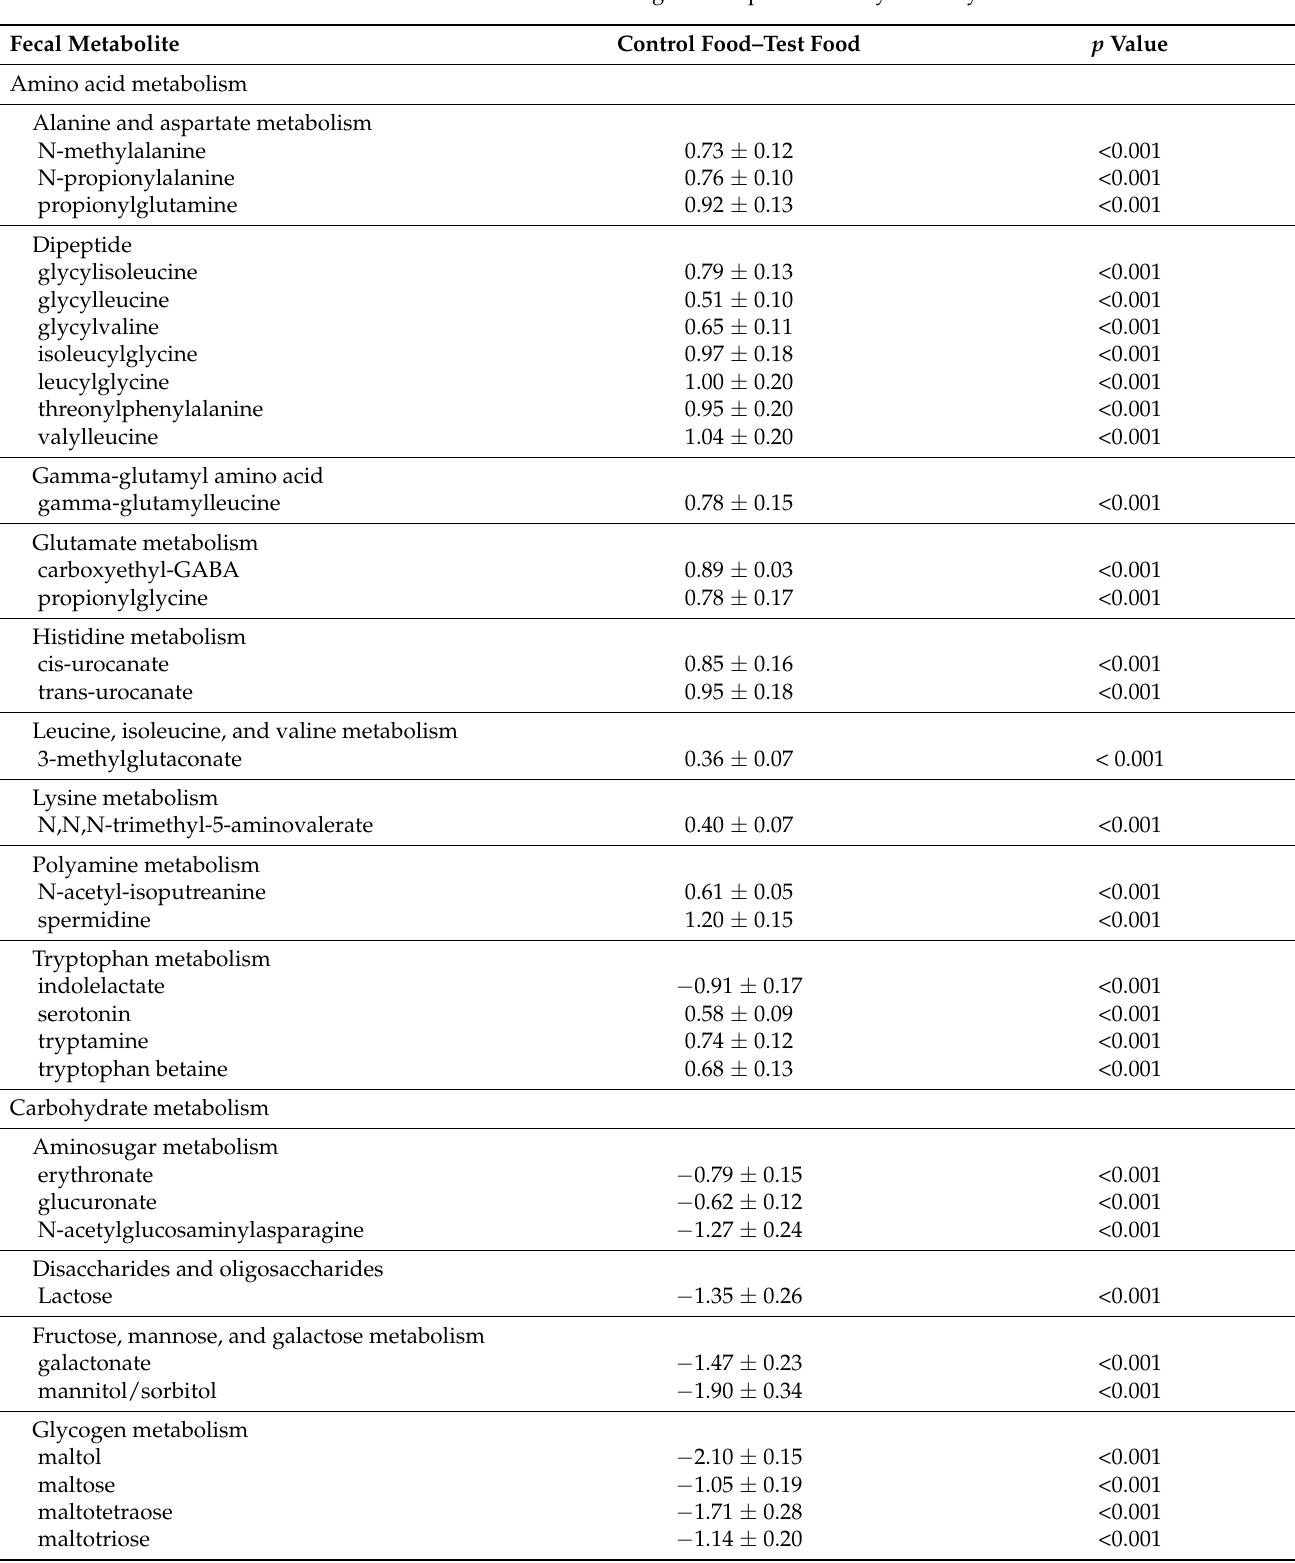
Table 6. Fecal metabolites of interest following consumption of study foods by senior